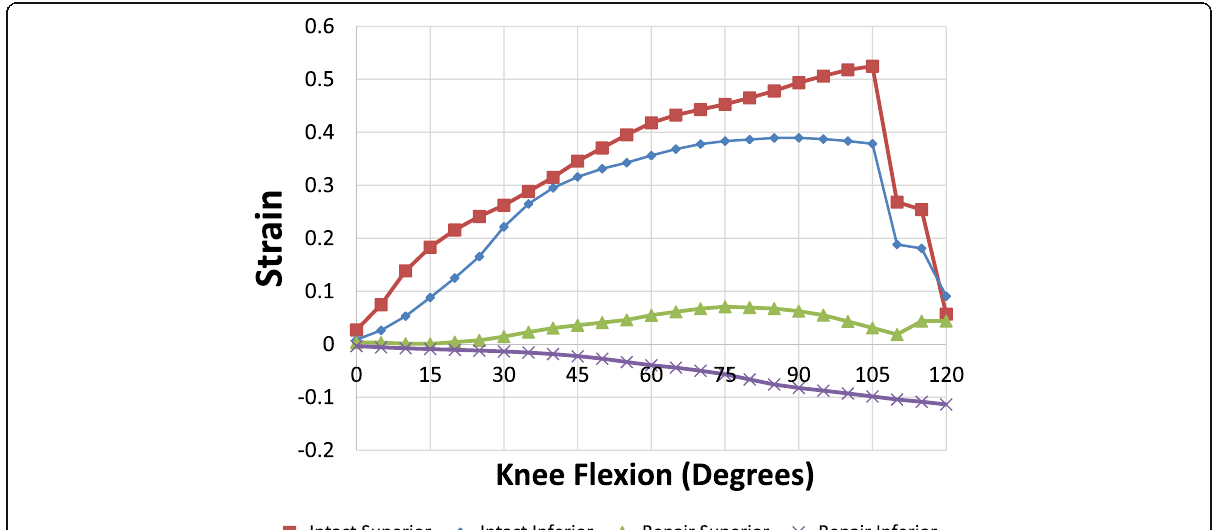
Fig. 6 Strain pattern of intact and reconstructed MPFL as knee flexed from 0 to 120 degrees. Red – superior intact, Blue – inferior intact, Green – superior reconstructed, Purple – inferior